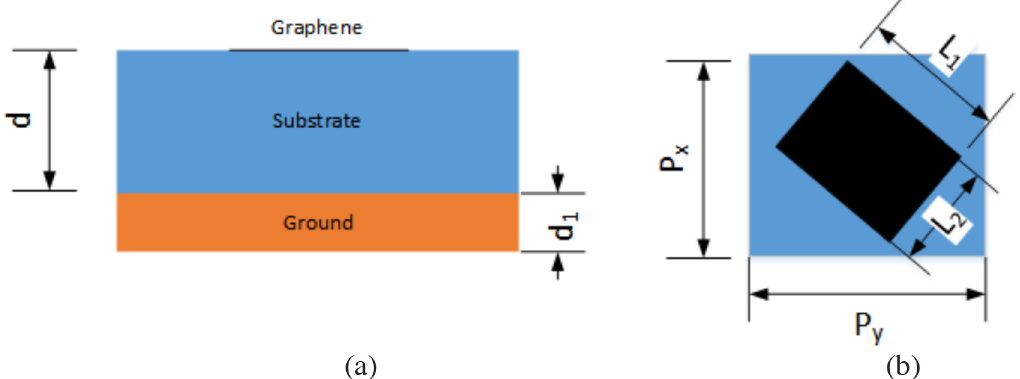
Fig. 1. (a) Side view of unit cell, (b) Top view of unit cell.